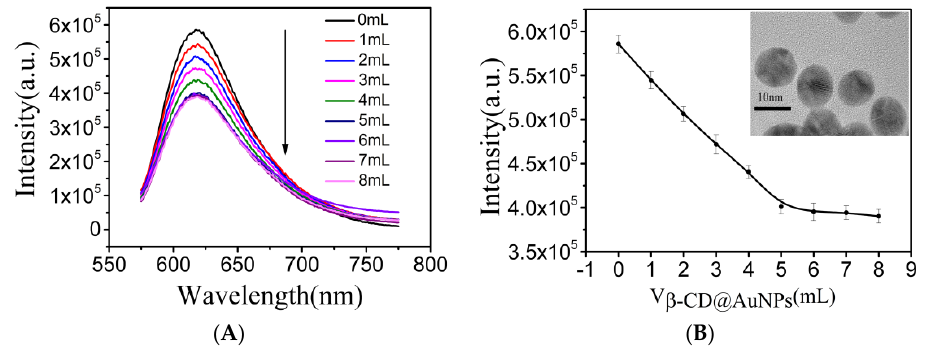
Figure 3. ( A ) Fluorescence spectra of the NR-β-CD@AuNPs when the volume of β-CD@AuNPs